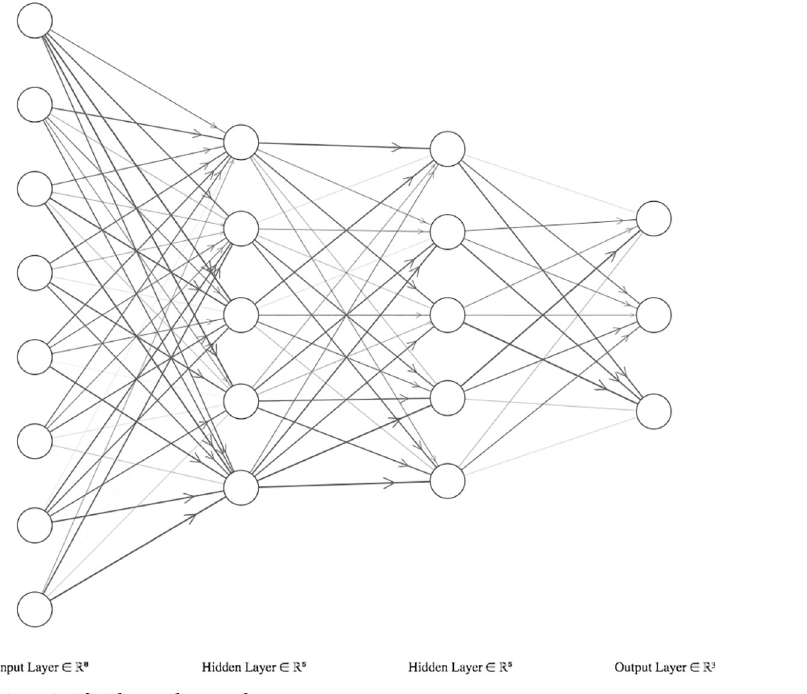
Fig 3. Artificial neural